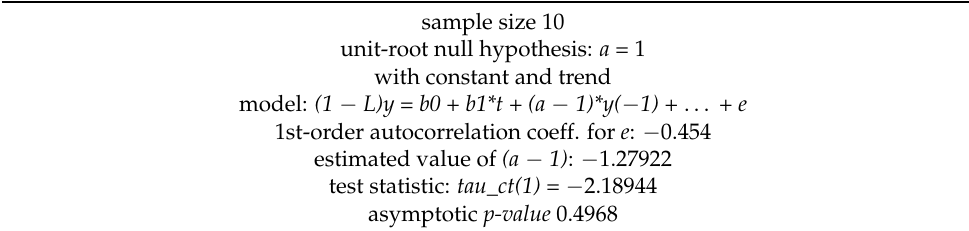
Table 2. Statistical properties of variables (ADF test) for L t including 2 lags of (1 − L) L t .